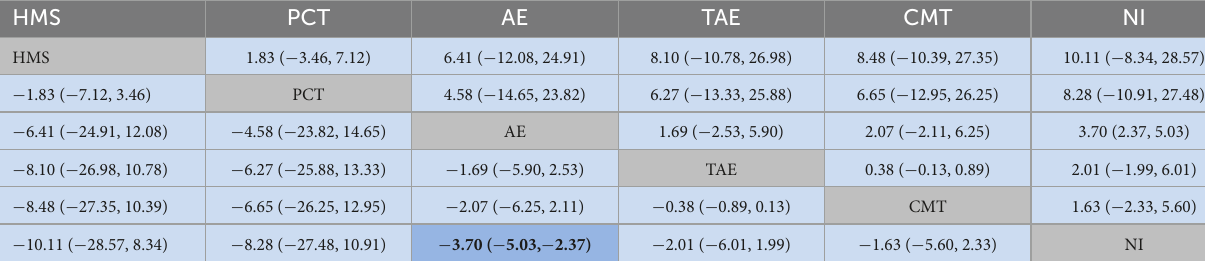
TABLE 4 League table on social